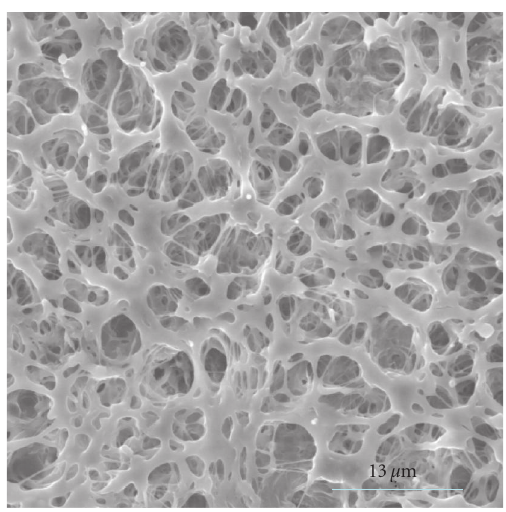
Figure 9: SEM image of collagen film surface after laser irradiation ( F = 1 . 7 J/cm 2 , 1 pulse, scale bar is 13 μ m).